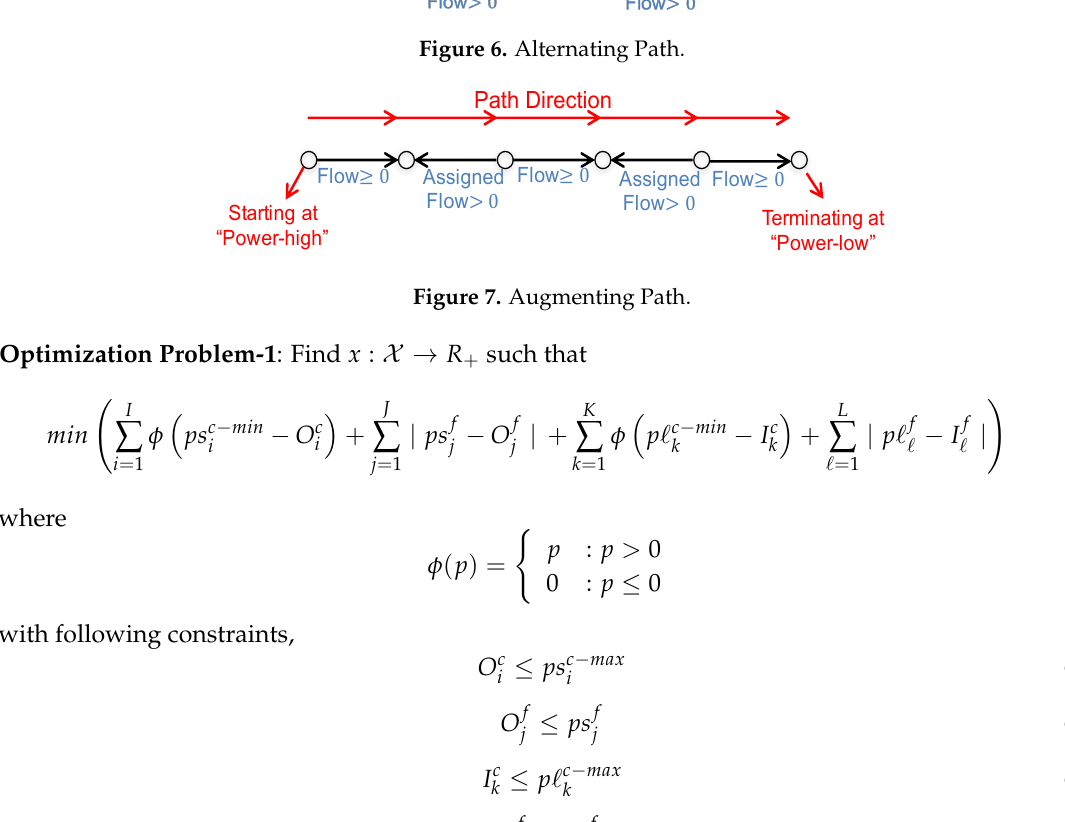
Figure 6. Alternating Path.